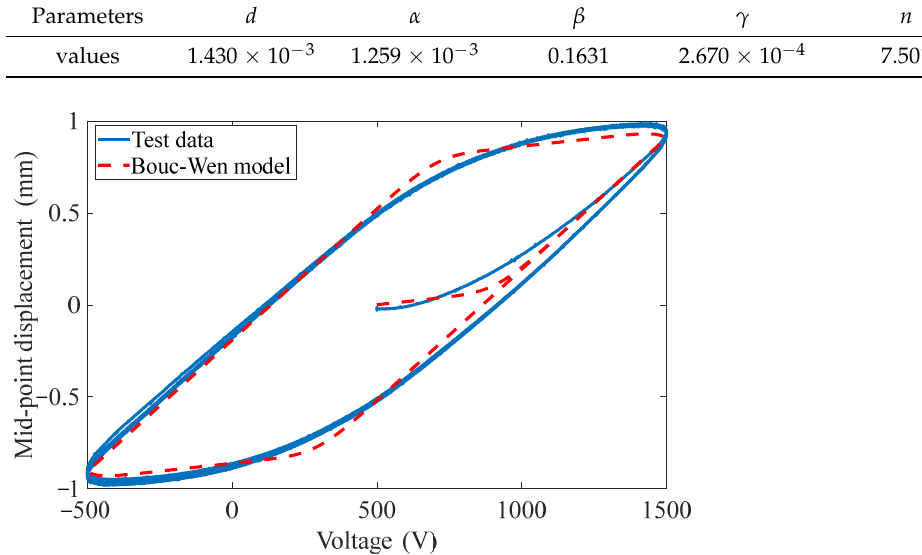
Figure 6. Identified quasi-static hysteresis loop based on Bouc–Wen model.